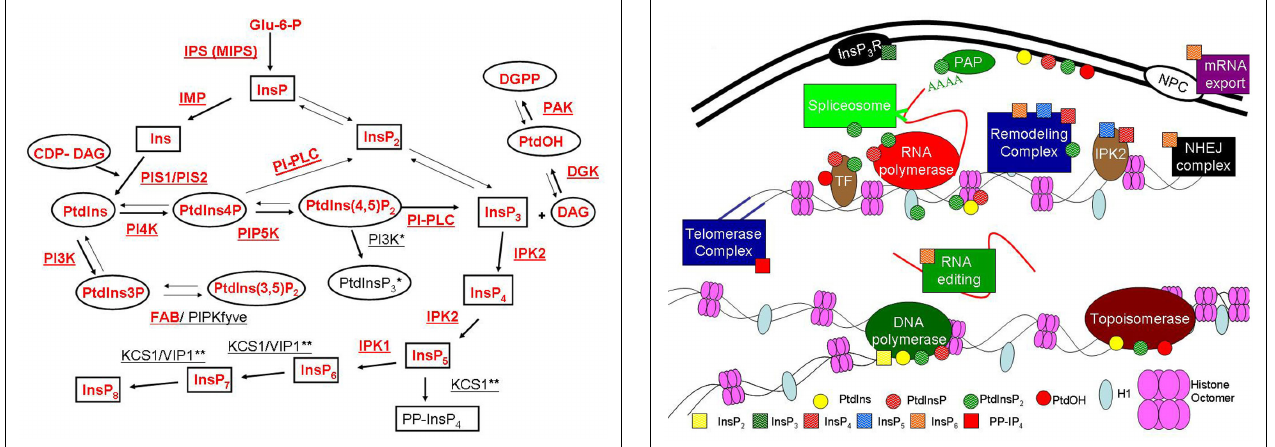
FIGURE 2 | Phosphoinositide pathway functions reported in animal and yeast nuclei. In animals and yeast, phospholipids and inositol phosphates are associated with many critical nuclear processes such as DNA repair, chromatin remodeling and RNA editing and export as described in the text. Nuclear enzymes affected by the PI pathway include: polyadenylate polymerase (PAP), topoisomerase, DNA polymerase and RNA polymerase. Nuclear proteins include: transcription factors (TF), inositol phosphate kinase 2 (IPK2, with transcription factor activity), inositol trisphosphate receptor (InsP 3 R), histone H1 (H1), histones 2A, 2B, 3 and 4 (Histone Octomer). Nuclear complexes include: DNA repair complex with Non-homologous end joining (NHEJ), RNA editing, mRNA export, Spliceosome, Remodeling complexes,Telomerase complex and the NPC – nuclear pore complex. Data are from both in vivo and in vitro assays. Small circles represent different phospholipids and small squares represent different inositol phosphates as